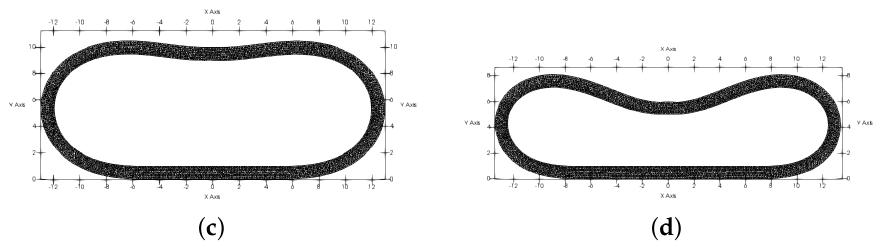
Figure 3. Ring, Ogden model: mesh deformation after: 0 ( a ), 5 ( b ), 10 ( c ) and 14 ( d ) increments.